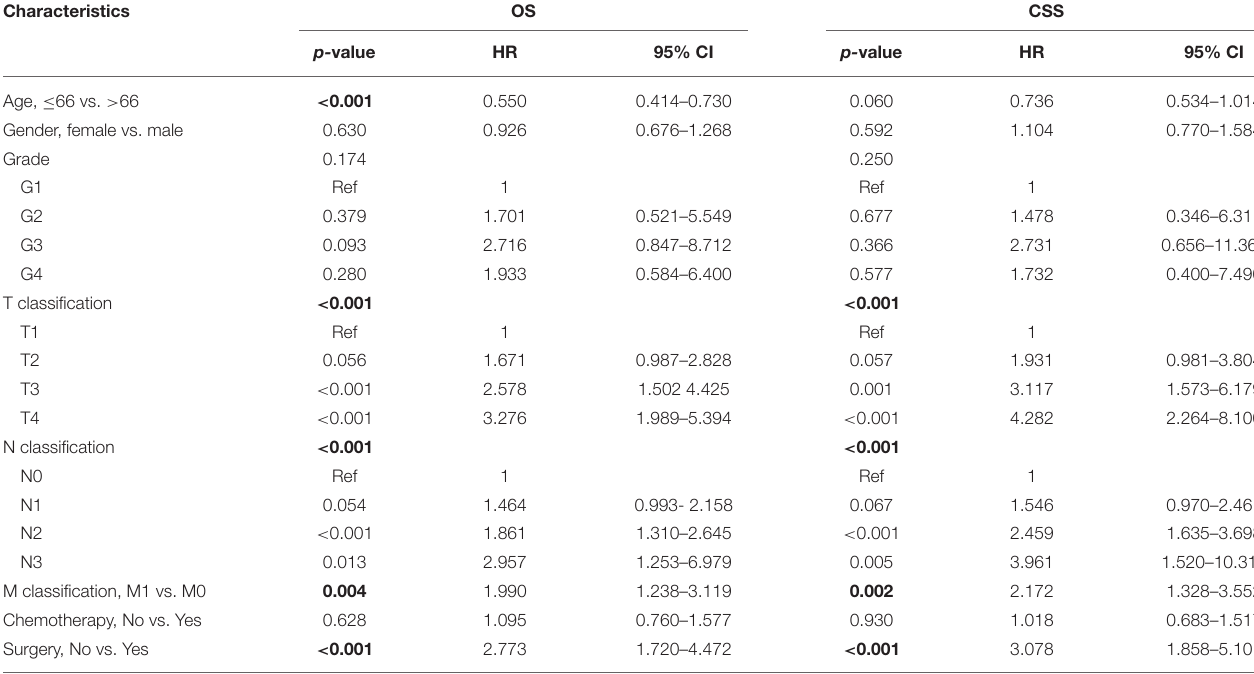
TABLE 2 | Multivariate Cox regression analyses of overall survival and cancer-specific survival. Characteristics